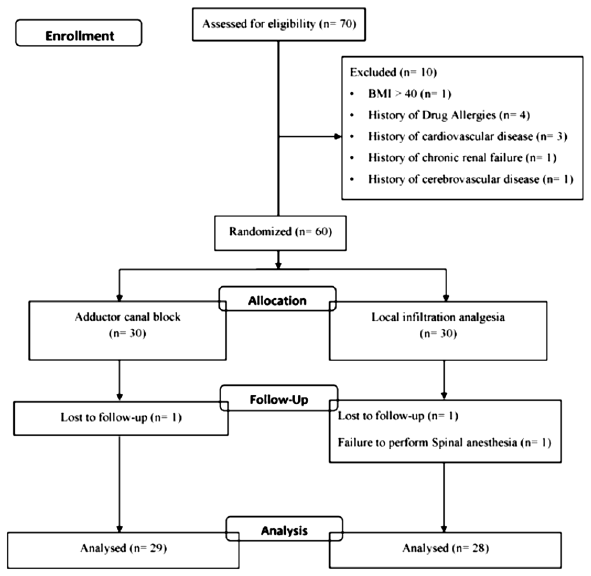
Consolidated standards of reporting trials statement Fig. 1: flow diagram.